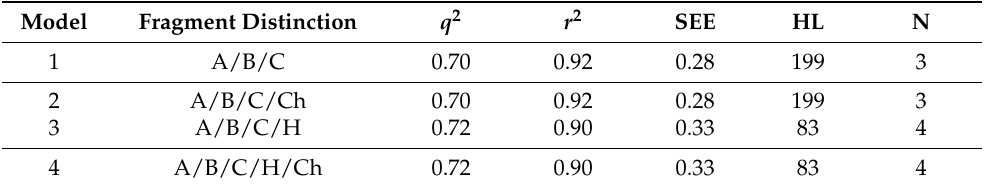
Table 2. Hologram quantitative structure–activity relationship (HQSAR) models obtained by using fragment sizes varying from 4 to 7